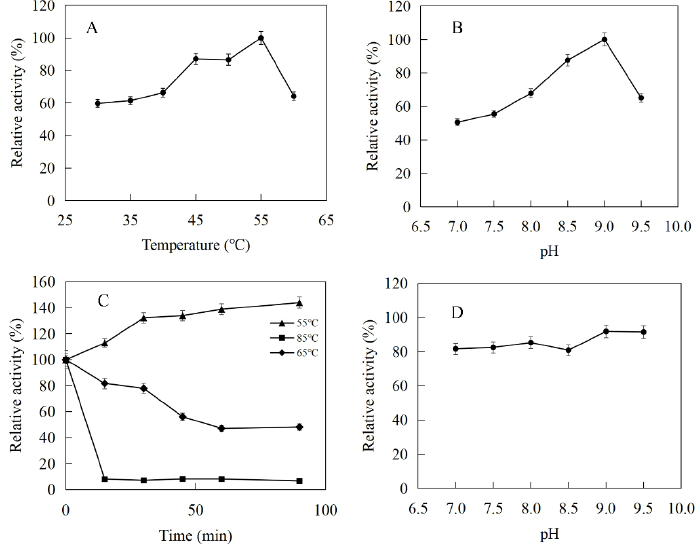
Figure 3. Effects of pH and temperature on the activity and stability of SfPK: ( A ) Effect of temperature on the activity of SfPK. ( B ) Effect of pH on the activity of SfPK. ( C ) Thermostability of SfPK. ( D ) pH stability of SfPK.